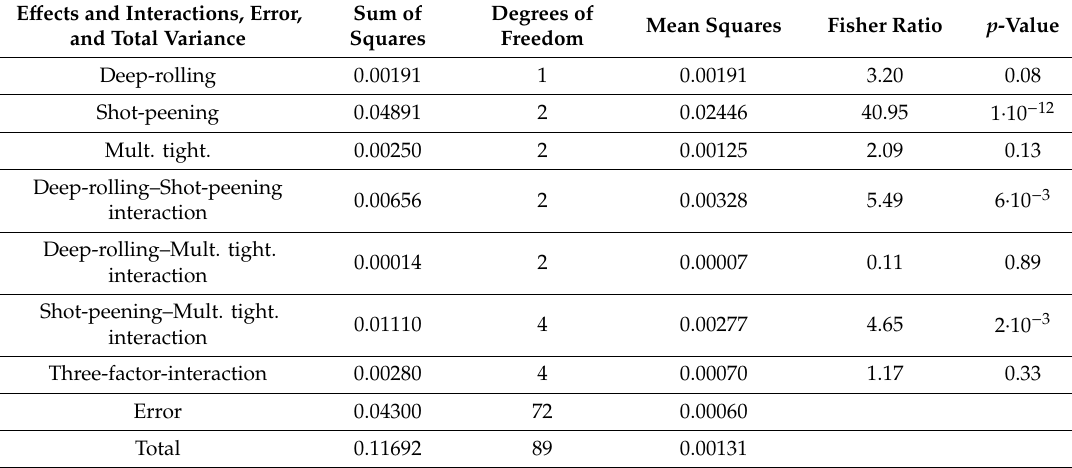
Table 8. ANOVA table with regard to the bearing friction coefficient (  b ) in lubricated conditions. Effects and interactions, Error,